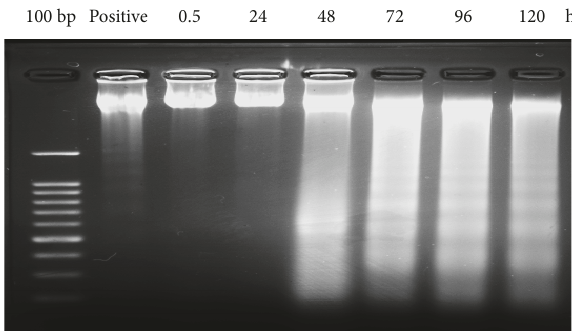
Figure 4: DNA fragmentation pattern in HeLa cells treated with ACE at half IC 50 by 2.5% agarose gel electrophoresis and ethidium bromide staining. Lane 1: 100bp DNAladder, lane 2: positive control (0.01% triton-x 100), lanes 3-8: ACE-treated cells for 0.5, 24, 48, 72, 96, and 120 h, respectively. The data are representative of three independent experiments addressed under the same